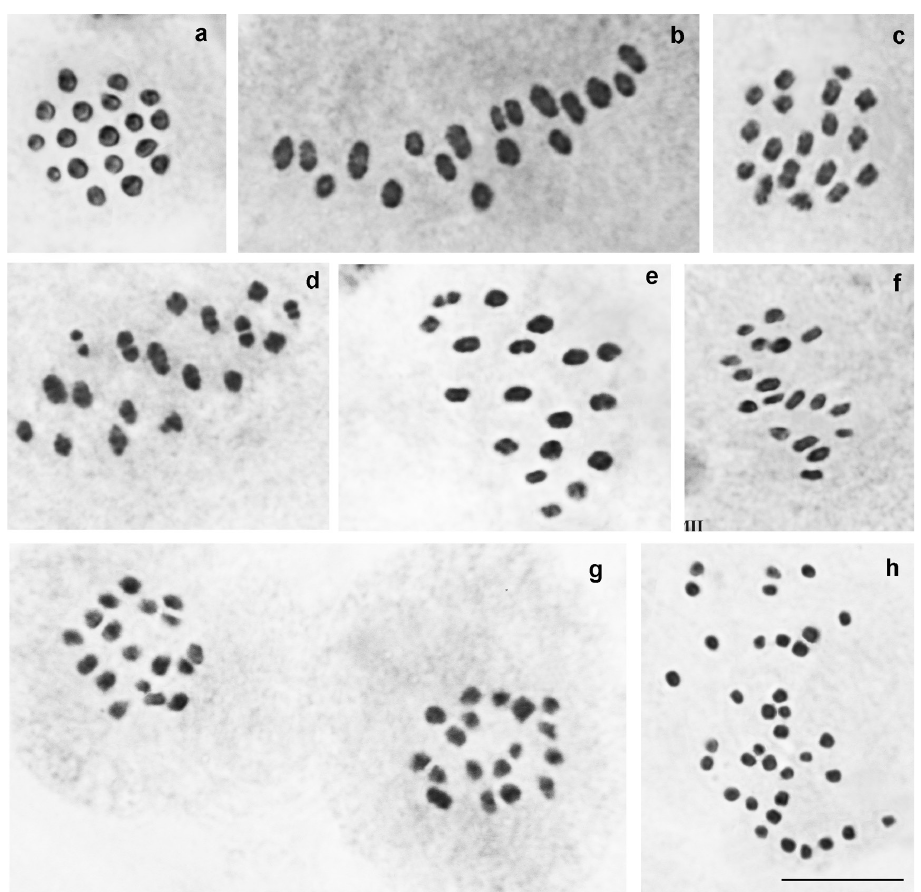
Figure 5. Karyotype of P. damonides elbursicus from Elburs Mts (north Iran). a sample M804, MI, n=17 b sample VL302, two MI plates, each displaying n=17 c sample VL302, diakinesis – early prometaphase, n=17 d sample VL302, prometaphase, n=17 e sample VL302, MII, n=17. Bar = 10